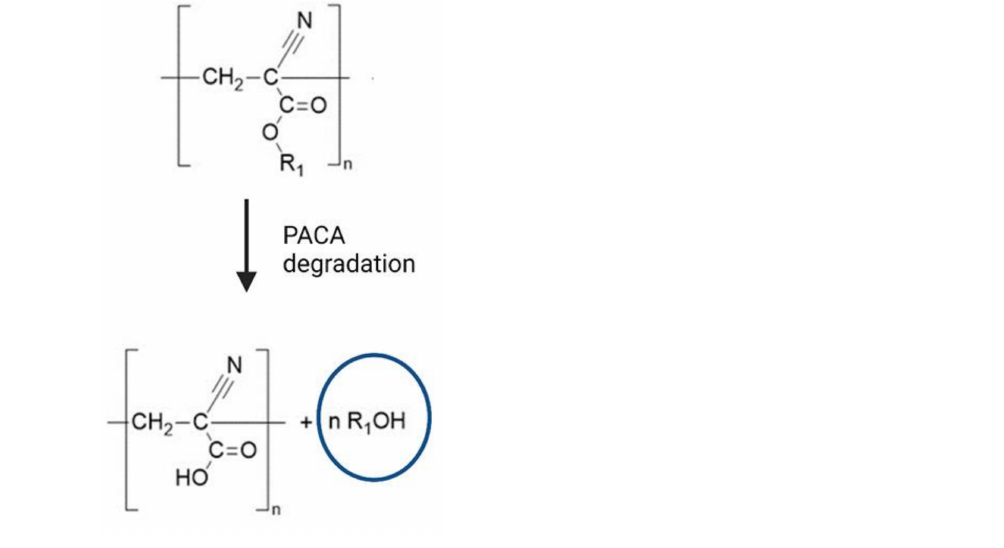
Figure 2. Structure of Poly (alkyl cyanoacrylate) (PACA). Reused from an open access article [127]. Mixing a solution that contains a fibrinogen source (from plasma, platelet-rich plasma), or heterologous/autologous cryoprecipitate) and factor XIII with another separate solution consisting of thrombin source (bovine, human, or recombinant), anti-fibrinolytic agent, and calcium to prevent rapid fibrinolysis is the most common method that is used to produce fibrin-based adhesive systems. When brought together, these substances cause the formation of a clot that is devoid of cells. During this process, thrombin cleaves